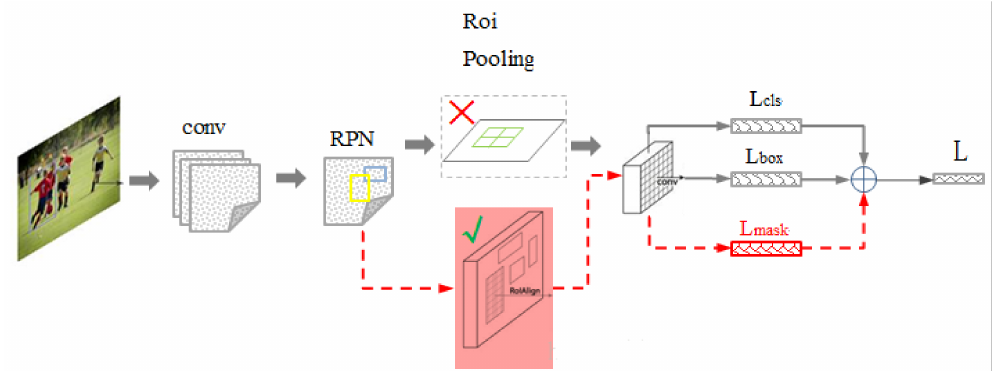
Figure 14. Adding mask branches based on Faster R-CNN